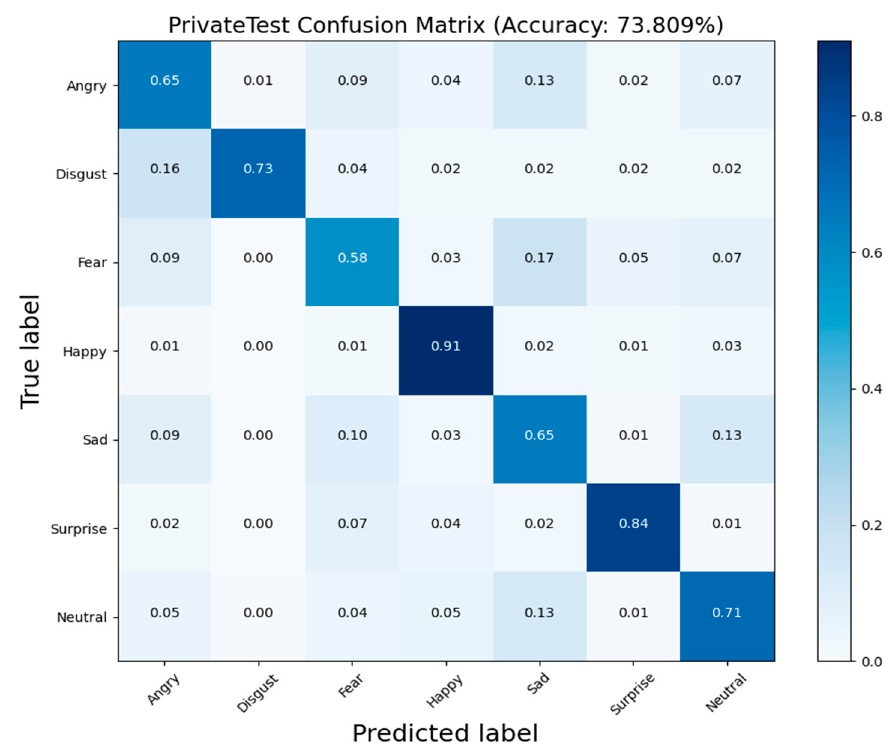
Figure 10. Confusion matrix for expression recognition in the FER2013 dataset.